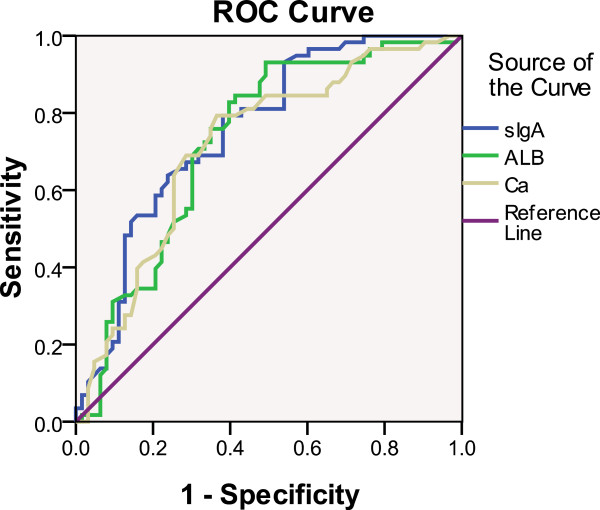
Respective ROC Curve of sIgA, ALB and Ca between IgAN and non-IgAN. ROC curves for serum immunoglobulin A level (sIgA), ALB (albumin) and Ca (calcium) in immunoglobulin A nephropathy (IgAN) and non-immunoglobulin A nephropathy (non-IgAN) patients. The state variable is IgAN.